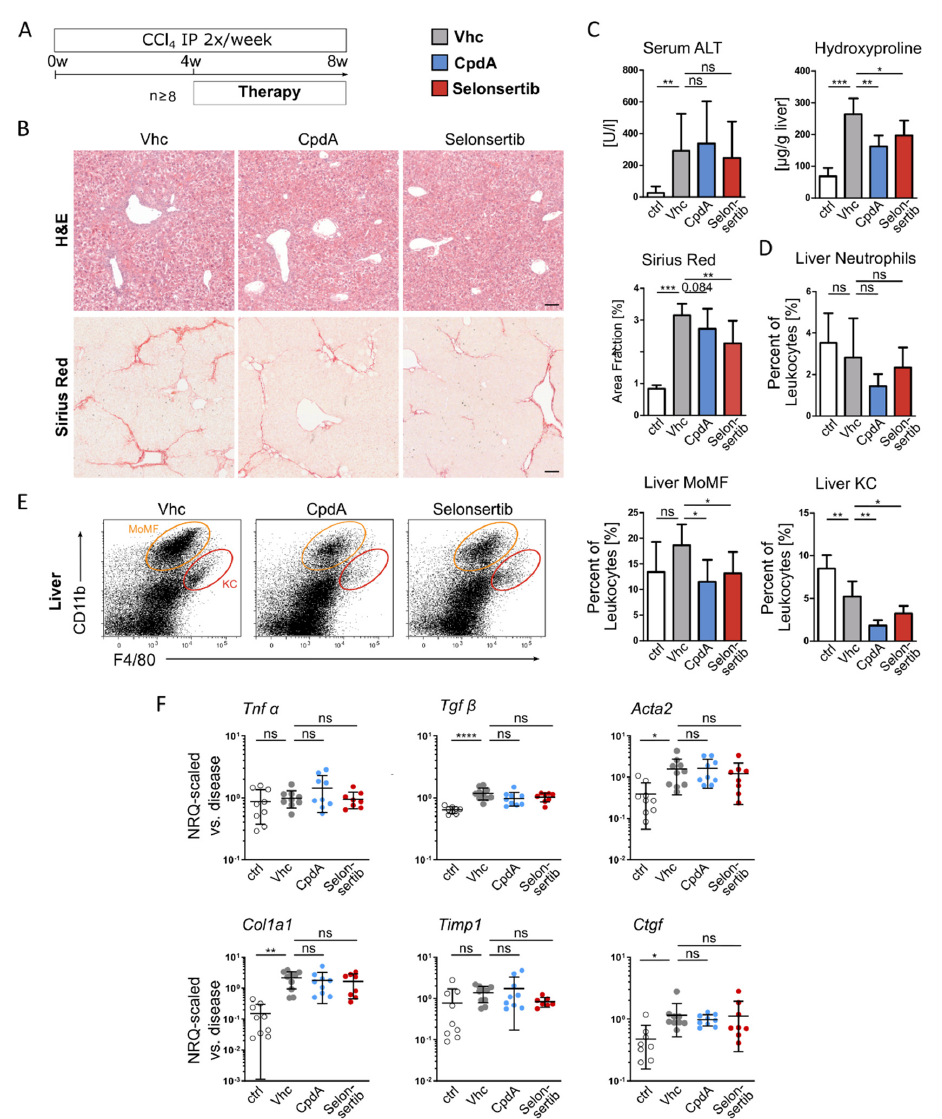
Figure 6. Impaired macrophage recruitment and reduced hepatic fibrosis by therapeutically antagonizing GPR84 in CCl 4 -induced liver fibrosis. ( A ) Liver fibrosis was induced by repetitive IP injections of CCl 4 (twice per week) for a period of 8 weeks ( n ≥ 8). GPR84 antagonist (CpdA, 30 mg/kg BW q.d.) and Selonsertib (15 mg/kg BW b.i.d.) were administered by oral gavage over the last 4 weeks of chronic injury induction. ( B ) Hepatic liver injury and fibrosis were assessed by H&E and Sirius-Red staining. ( C ) Quantification of Sirius-Red-positive area fraction, hepatic hydroxyproline content, and ALT serum levels. ( D–E ) Analysis of immune cell infiltration by FACS, revealing reduced macrophage numbers upon pharmacological inhibition of GPR84 or ASK1. ( F ) Expression levels of genes related to inflammation and fibrosis by RT-qPCR in total liver. All images were taken at ×10 objective magnification; scale bar, 100 µm. Data are presented as mean ± SD based on n ≥ 8 per group. * p < 0.05, ** p < 0.01, *** p < 0.001 (one-way ANOVA). Abbreviations: CpdA/B, compound A/B; KC, Kupffer cells; MoMF, monocyte-derived macrophages; Vhc, vehicle; Tnf α , tumor necrosis factor alpha; Tgf β , transforming growth factor beta; Acta2, alpha-actin-2; Col1a1, collagen type I, alpha 1; Timp1, tissue inhibitor of metalloproteinases 1; and Ctgf, connective tissue growth factor. Taken together, GPR84 inhibition e ff ectively inhibited myeloid cell infiltration upon liver injury induction in di ff erent experimental mouse models, consistently ameliorating liver inflammation and fibrosis upon chronic liver